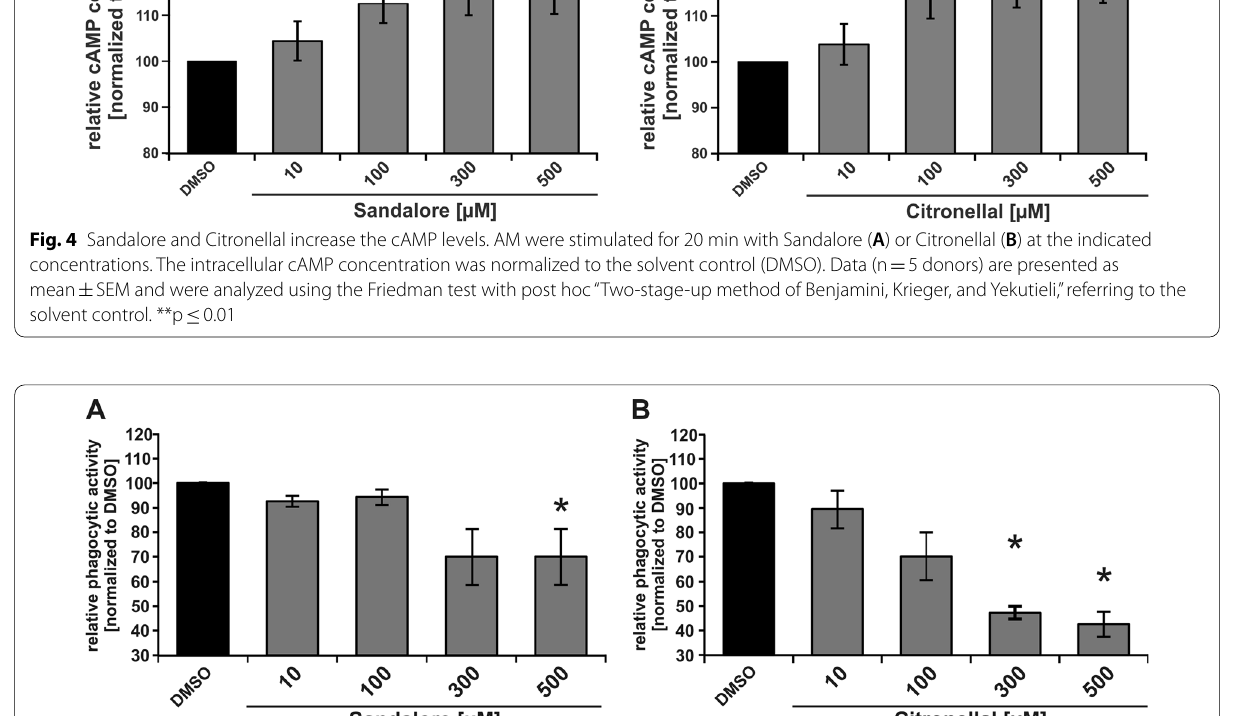
Fig. 5 Sandalore and Citronellal reduce the phagocytic activity of AM. AM were incubated for two hours with fluorescent latex beads and Sandalore ( A ) or Citronellal ( B ). The amount of phagocytosed beads was determined by flow cytometry. Data were normalized to solvent controls (DMSO). Data (n 3 donors) are presented as mean SEM and were analyzed using the Friedman test with post hoc “Two-stage-up method of = ± Benjamini, Krieger, and Yekutieli,” referring to the solvent control. *p <